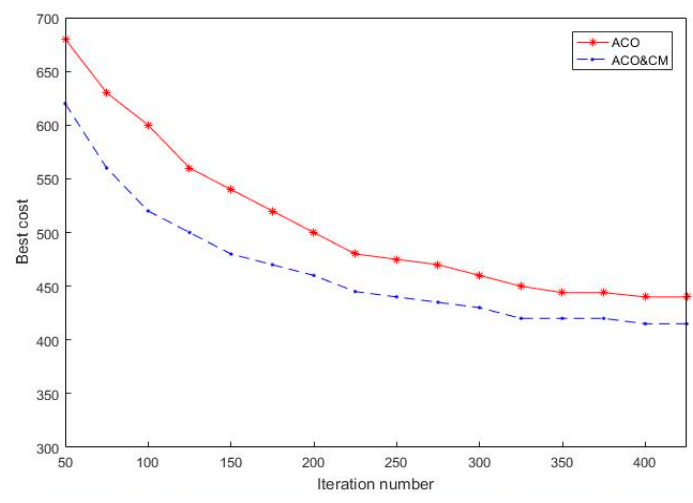
Figure 7. Comparison of the convergence of ACO and ACO&CM.